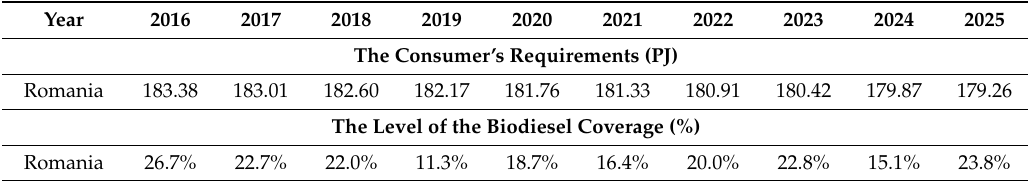
Table 16. The consumer’s requirements for diesel fuel and the biodiesel coverage. Source: authors’ own calculation based on